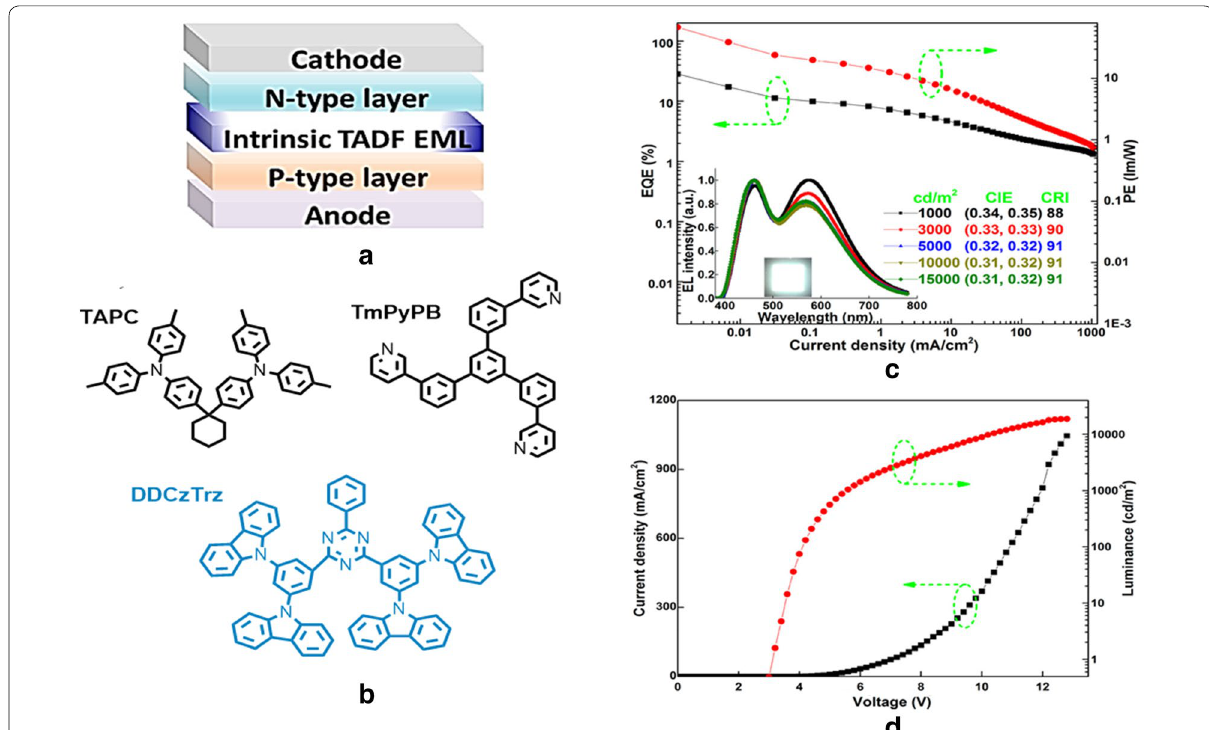
Fig. 22 a Device configuration, b molecular structures of TAPC, TmPyPB, and DDCzTrz, c EQE and PE of W1. Inset: EL spectra at various luminances and an image of the WOLED, d current density and luminance of W1 (Reproduced with permission from Ref. [53] Copyright © 2018, American Chemical